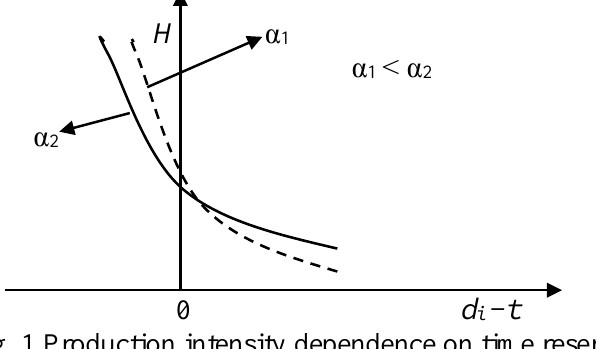
Fig. 1 Production intensity dependence on time reserve